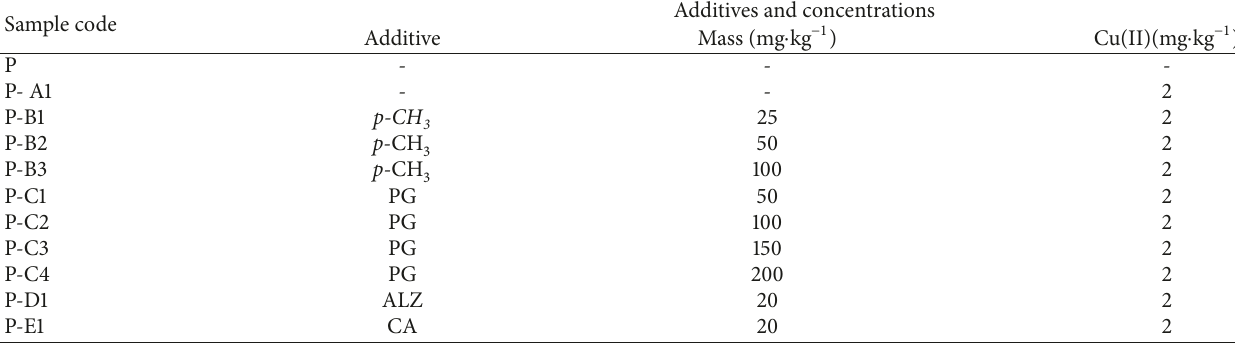
Table 1: Details of control and doped samples with different concentrations of additives. Sample